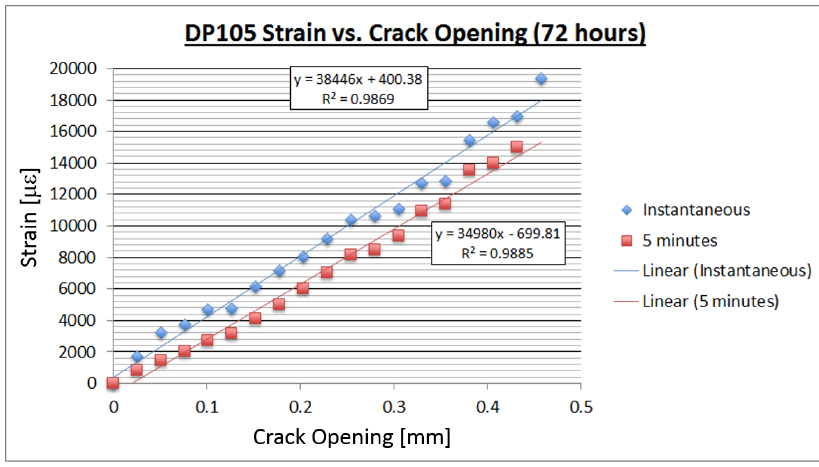
Figure 13. DP105 crack opening vs. strain after 72